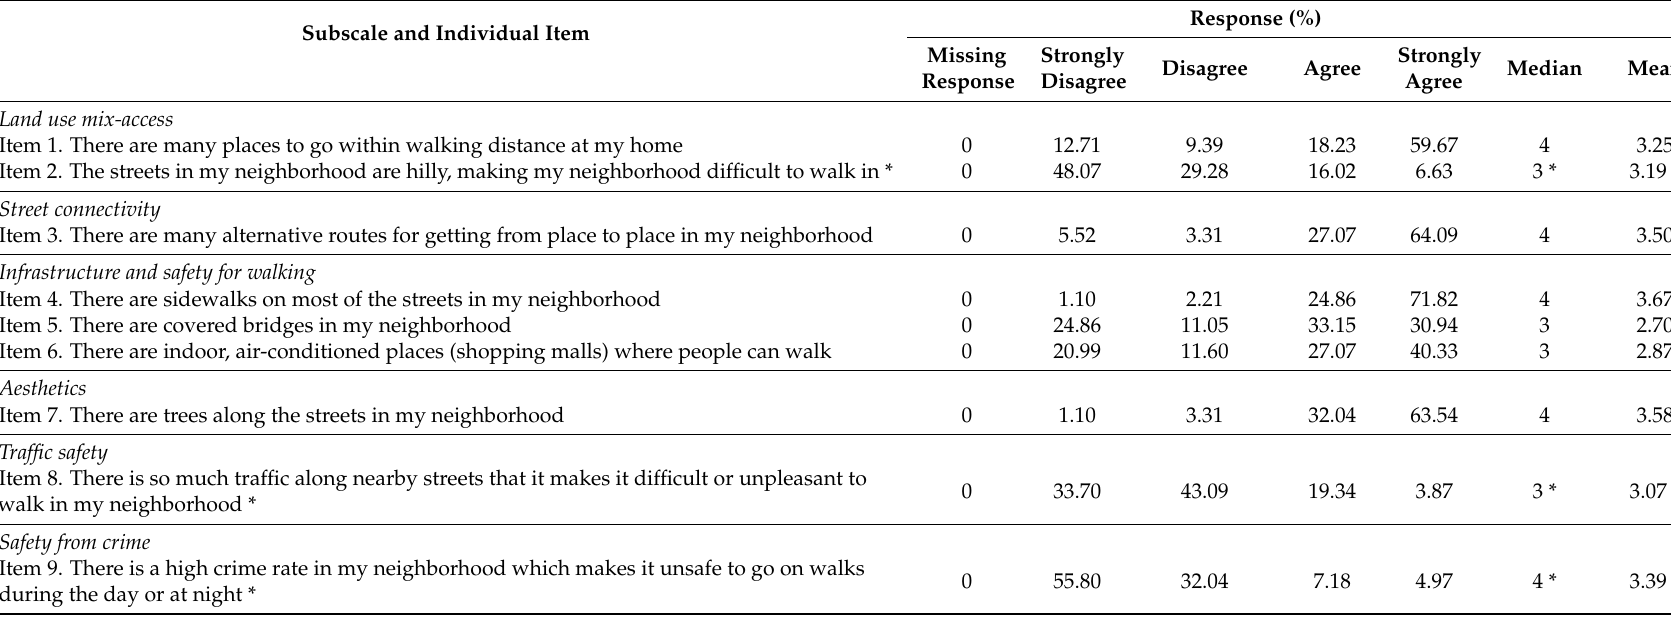
Table 2. Descriptive statistics of perceived neighborhood walkability ( n =